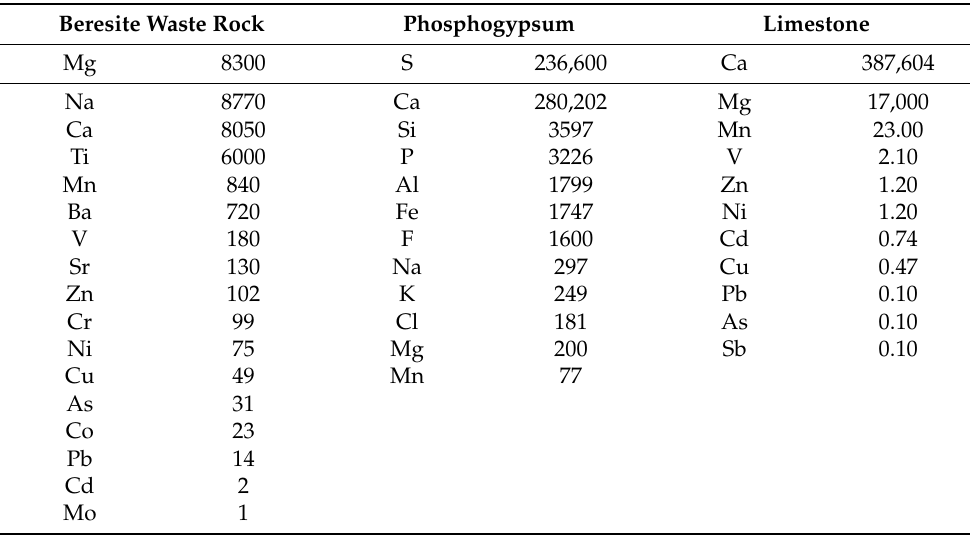
Table 3. The average element composition of used mine waste,